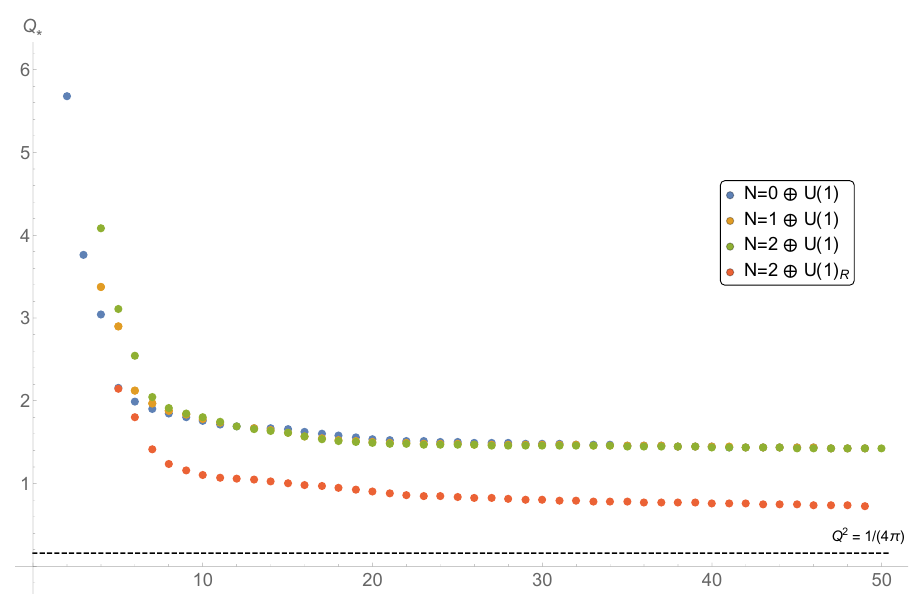
Figure 13 . Lower bounds on the highest charge. There must be at least one charged state with the charge greater than the bound. The level of U(1) current was normalized by 1. Notice that the three cases for the non-R U(1) charge bounds almost